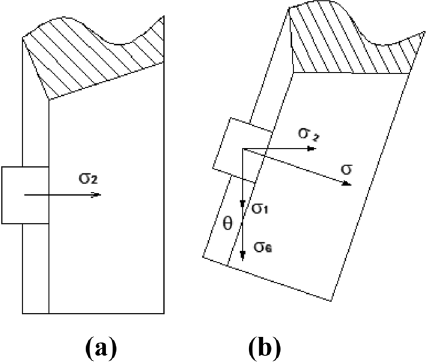
Figure 4. The contrast in seed-filling stress of two kinds of seed-metering devices. ( a ) Vertical seed-metering device; ( b ) inclined seed-metering device.